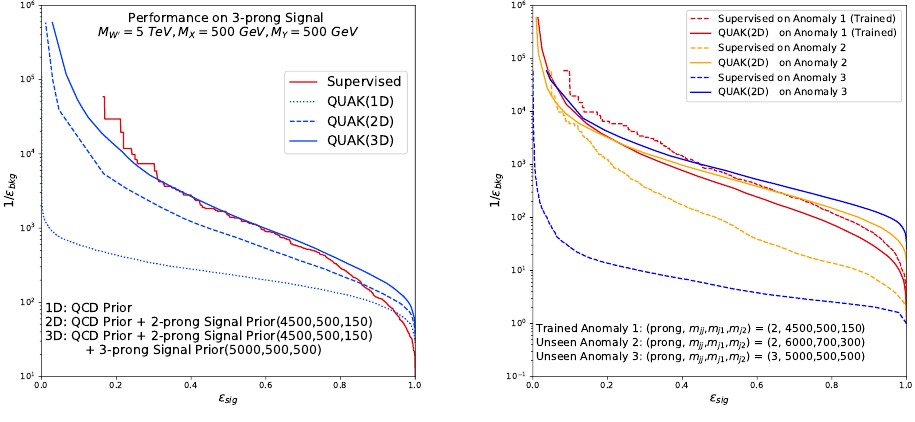
Figure 9 . (Left) Receiver Operator Characteristic (ROC) for a resonant signal compared to QCD background; the resonant signal has mass m jj = 5 TeV that decays into two three-pronged objects with mass m j 1 = m j 2 = 500 GeV against a background. Signal priors are labeled in the legend by ( m jj , m j 1 , m j 2 ) . Performances are shown in blue for the 1D QUAK (QCD prior only), 2D QUAK (QCD prior and a 2-prong signal prior) , and 3D QUAK (+ 3-prong signal prior), and shown in red for a fully supervised training on the true signal prior against background. Jet masses ( m j 1 , m j 2 ) are excluded in the training of the supervised classifier to mitigate model dependence. (Right) ROC for signal versus QCD background computed from a selection on two neural networks consisting of: QUAK(2D) (solid) for one network and a supervised network (dashed) for the other network. Both networks are trained once and constructed using the same 2-prong signal prior. The networks are then applied to different signal models. For both QUAK and the supervised network a signal prior of a resonance W 0 → XY with X and Y decaying to pairs of quarks having masses (4500 , 500 , 150) is used in the